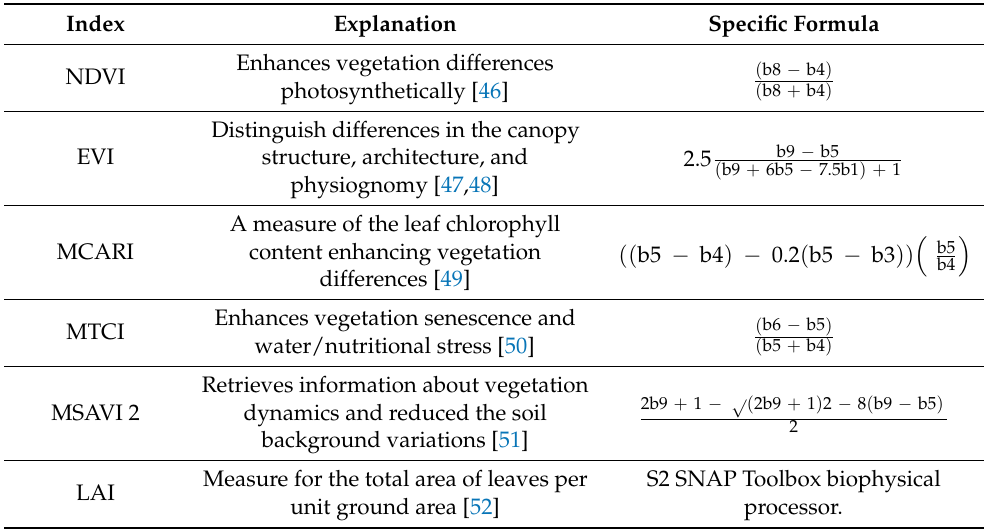
Table 1. List of spectral vegetation indices and biophysical variables used to support A. longifolia supervised classification and